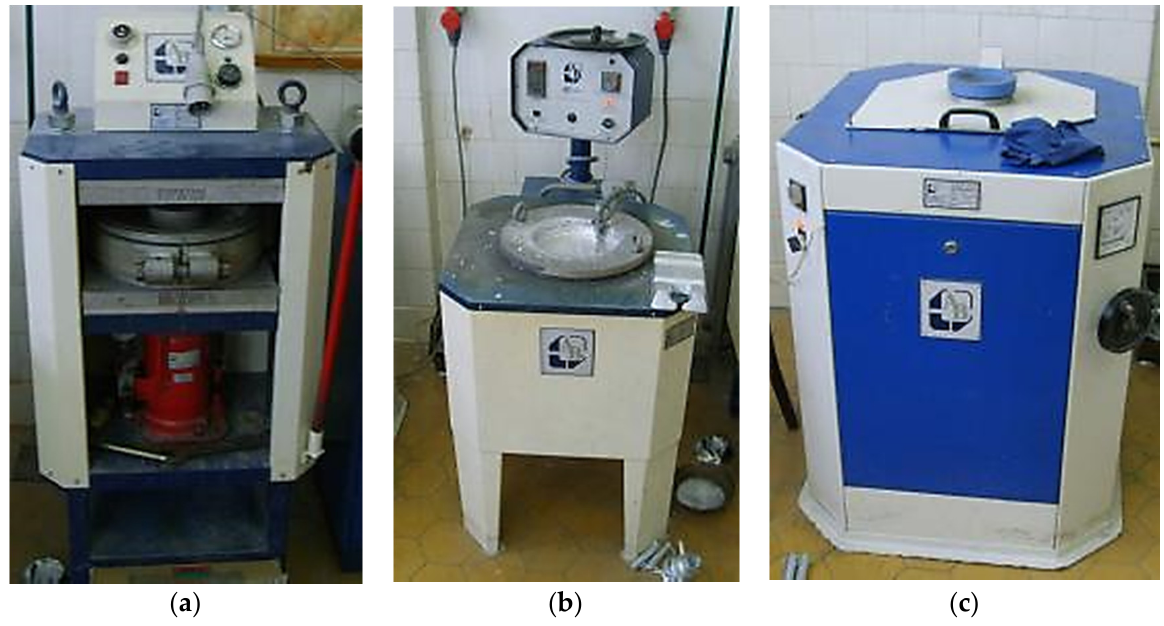
Figure 1. Equipment for centrifugal casting: ( a ) vulcanizer, ( b ) melting furnace, and ( c ) centrifuge. After each cast, a fluidity test, static tensile test, Brinell hardness test, metallographic evaluation, and a fractographic evaluation were performed. The casting of all test specimens was performed with identical conditions, which are listed in Table 3.